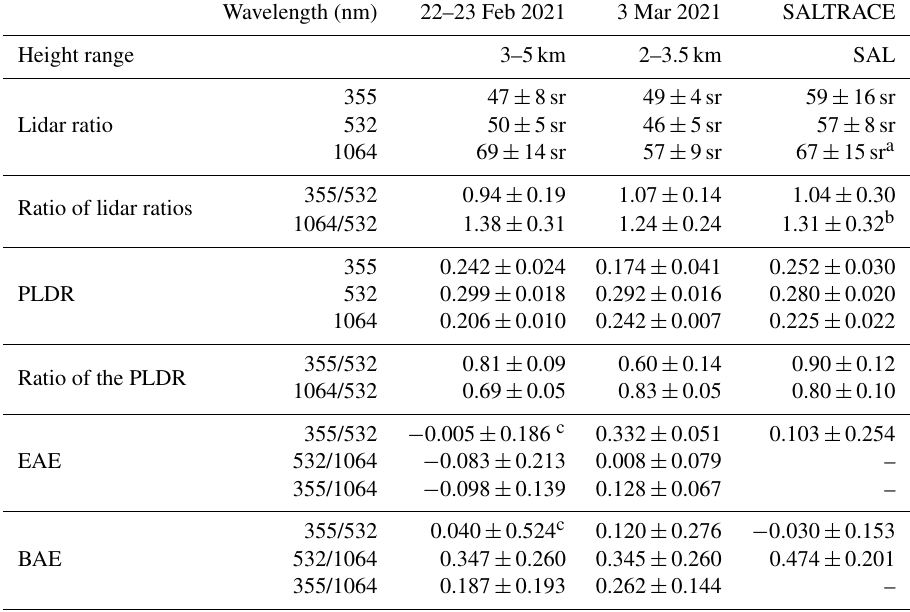
Table 1. Intensive optical properties of Saharan dust observed at Leipzig on 22–23 February (pure-dust case) and 3 March 2021 (slightly polluted-dust case). For comparison, the optical properties of long-range-transported Saharan dust at Barbados as observed during the SALTRACE campaign are provided; the PLDR values during SALTRACE are taken from Haarig et al. (2017). The PLDR values of the Leipzig cases are reported for the triple-wavelength depolarization setup of the measurement (first 20min), whereas the other properties are reported for the triple-wavelength extinction measurement. SAL – Saharan air layer, PLDR – particle linear depolarization ratio, EAE – extinction Ångström exponent, BAE – backscatter Ångström